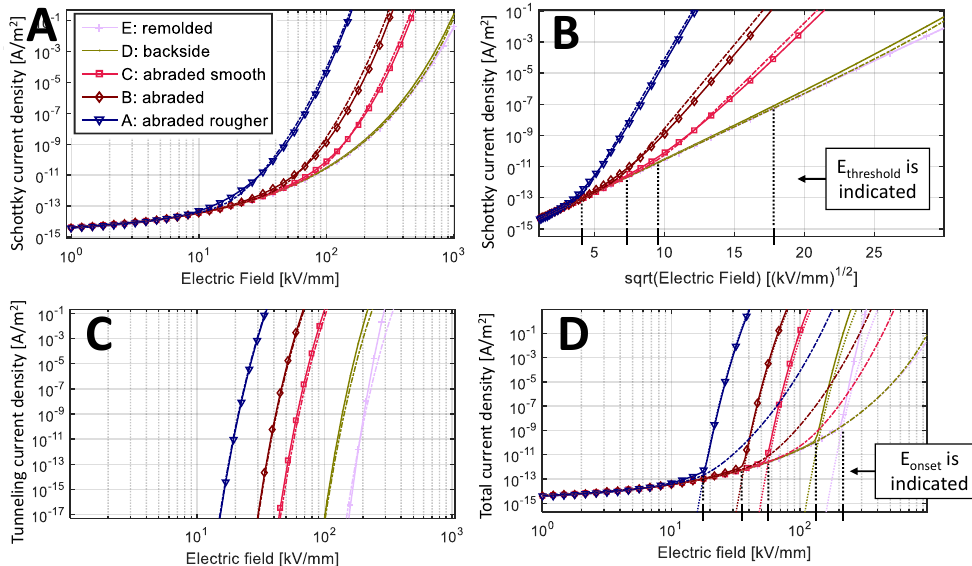
Figure 5. Calculated injection characteristics at 25 °C (solid lines with markers) using the Laplacian field enhancement factors ( FEF) distributions and fitted curves using Equation (7) and Equation (8) (dash-dotted lines). A 1.5 eV barrier height was used in the calculations. Schottky currents are shown in a double logarithmic plot ( A , top left) and a Schottky plot ( B , top right). Fowler–Nordheim injection ( C , bottom left) is displayed in a double logarithmic plot. The total current ( D , bottom right) corresponds to the sum of the Schottky and Folwer-Nordheim injection current densities. Table 1. Sa parameters, Sdq parameters, maximal field enhancement, and used field parameters for the di ff erent surface types.